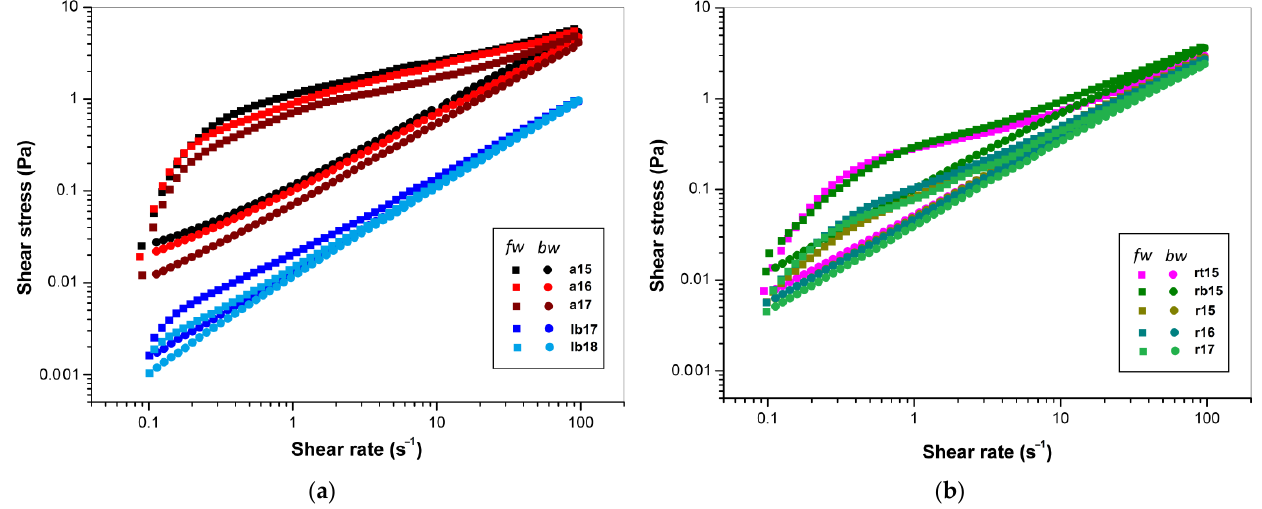
Figure 1. Plot of shear stress versus shear rate (on a double logarithmic scale) for 1% aqueous FSM solutions in the forward (squares) and backward (circles) directions: ( a ) Amon and Libra Bio cultivars; ( b ) Recital and Raciol cultivars.